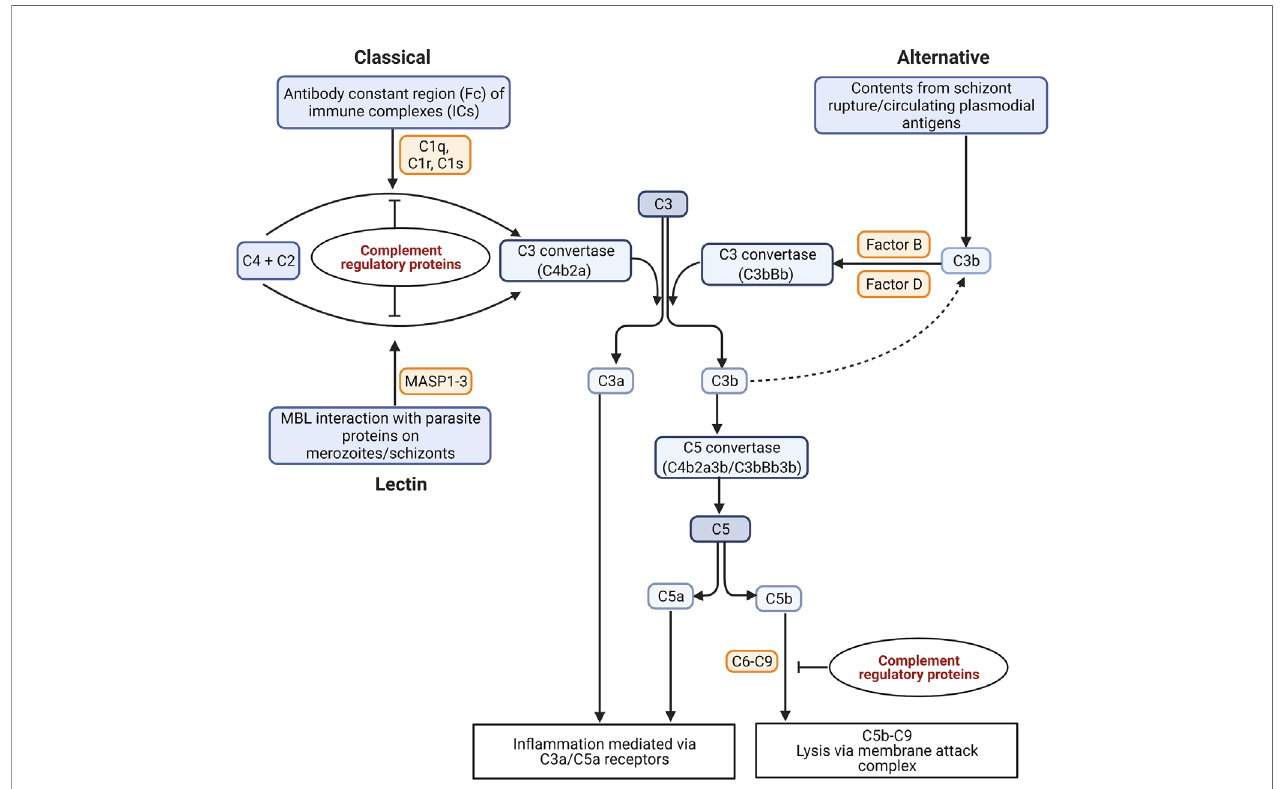
FIGURE 2 | Possible mechanisms of complement activation in malaria. The binding of C1q to antigen-antibody immune complexes (ICs) activates the classical pathway. The lectin pathway can be activated through the binding of mannose with the parasite proteins expressed on schizont surface. The serine proteases MASP1 and MASP2 (Mannan-binding lectin-associated serine proteases 1 and 2) bind to MBL in lectin pathway, and C1r and C1s bind to C1q to cleave two inactive proenzymes C4 and C2 in serum to produce C3 convertase (C4b2a). The alternative pathway is activated either by circulating plasmodial antigens, or products of schizont rupture like hematin. The spontaneous hydrolysis of C3 leads to the cleavage of factor B in serum by an active serum protease called factor D to form a distinct C3 convertase of the alternative pathway (C3bBb). The C3 convertases cleave C3 into C3a and C3b. The products of C3 and C5 cleavage, C3a and C5a, act as anaphylatoxins and interact with immune cell receptors (C3aR and C5aR) to drive in fl ammation. The assembly of C3b with the C3 convertases produces a C5 convertase (C4b2a3b/C3bBb3b) that can cleave C5 into C5a and C5b. The C5b recruits the factors C6, C7, C8, and C9 for the assembly of the membrane attack complex (MAC) (C5b-C9 or terminal complement complex) for cytolysis (14). [Figure adapted from